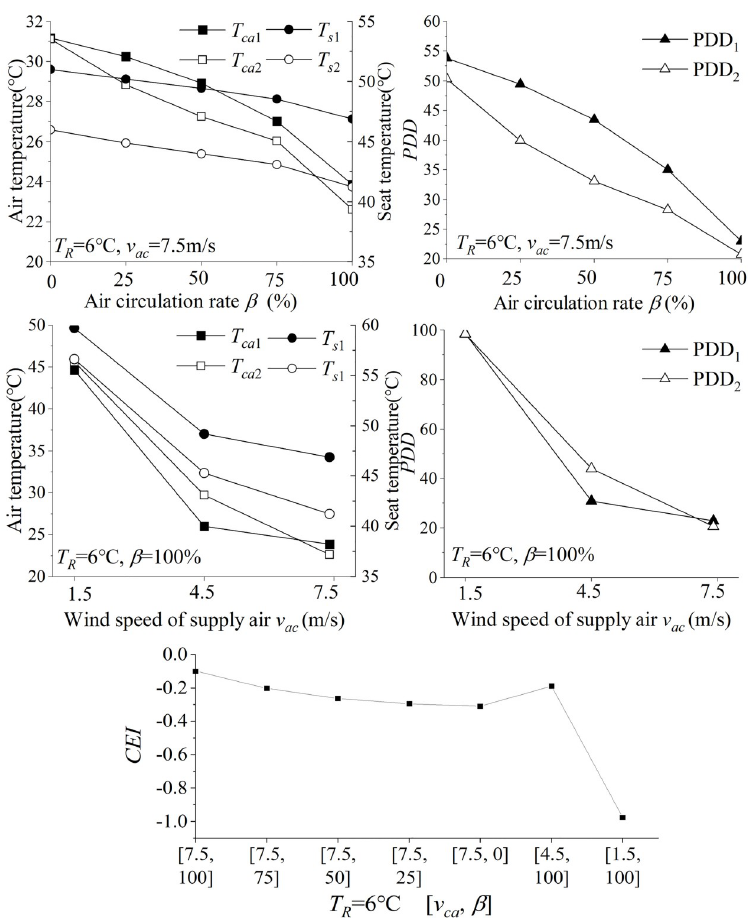
Fig 11. Influence of different parameter combinations on scenario 1. Compared with others, the parameter scheme [6, 7.5, 100] wins the highest score, with a CEI being -0.099.